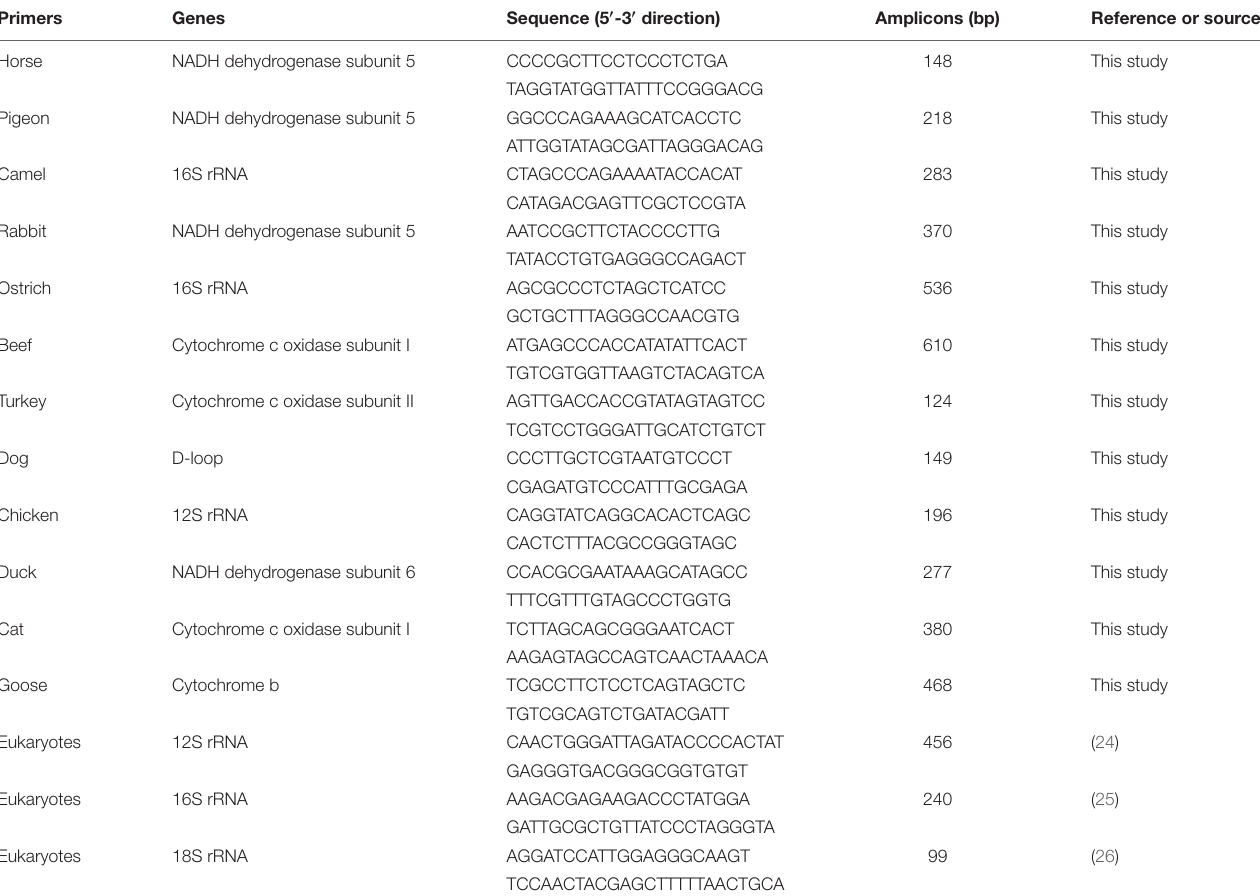
TABLE 1 | Oligonucleotide primers for the meat species used in this study. Primers Genes Sequence (5 (cid:48) -3 (cid:48) direction) Amplicons (bp) Reference or